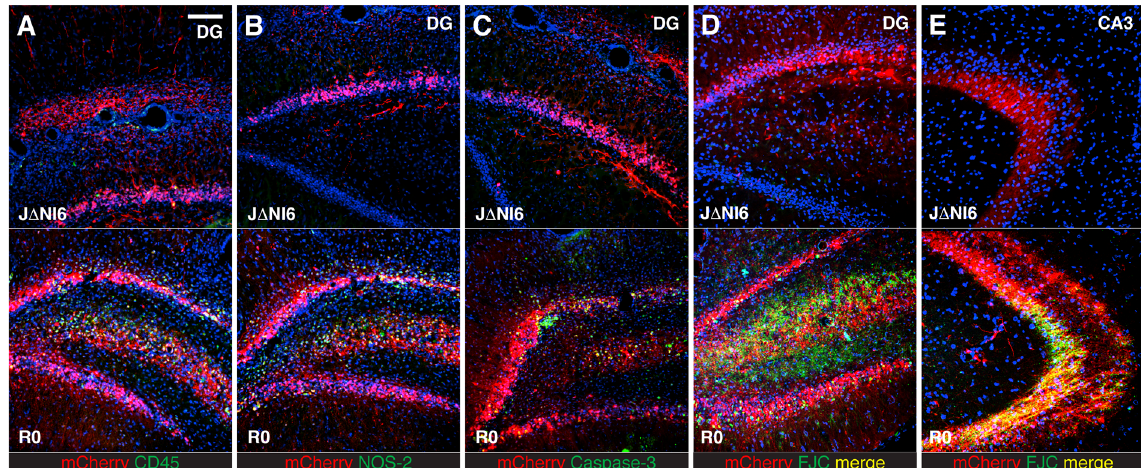
Figure 7. Safety of the J Δ NI6 vector. Comparative effect of the J Δ NI6 vector (upper panels) and the R0 vector (lower panels) on lymphocyte infiltration detected with anti-CD45 antibody ( A ), oxidative stress detected with anti-NOS-2 ( B ), apoptosis detected with anti-activated caspase 3 ( C ), and neuronal damage detected using fluoro-jade C (FJC, D – E ). Animals (4 per group) were killed 1 week after vector injection into the hippocampus, and images were taken at the level of the dentate gyrus (DG), near the site of vector injection ( A – D ) and in the CA3 area, site of axon terminals from dentate gyrus granule cells ( E ). Native mCherry fluorescence in red; nuclei stained in blue with DAPI; CD45, NOS-2, caspase-3 and FJC staining in green in panels (A,B,C, and D, E), respectively. Horizontal bar in ( A ) (for all panels) = 100 μ